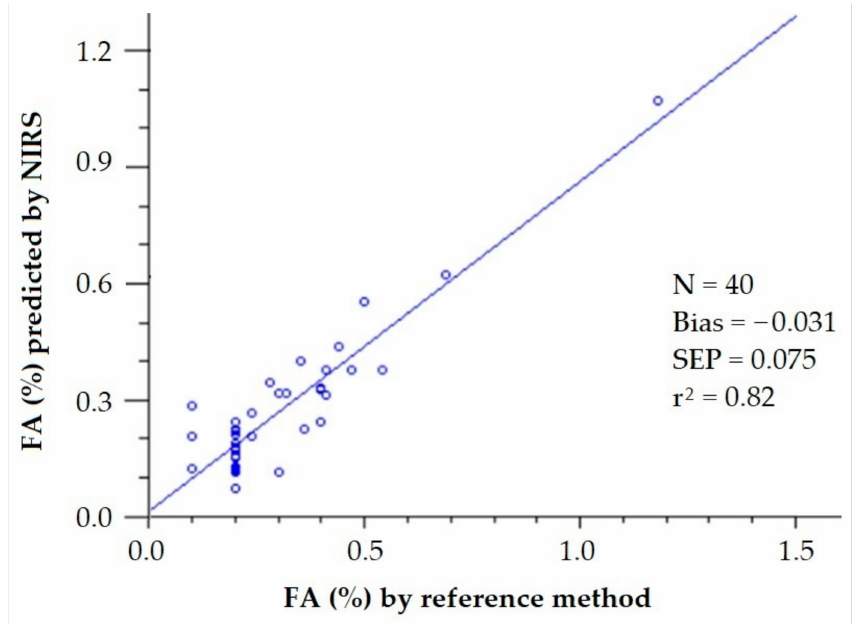
Figure 8. Validation exercise for the determination of the free acidity of olive oil by PLS-NIRS using all the wavelengths between 800 and 2200 (FA values retrieved from